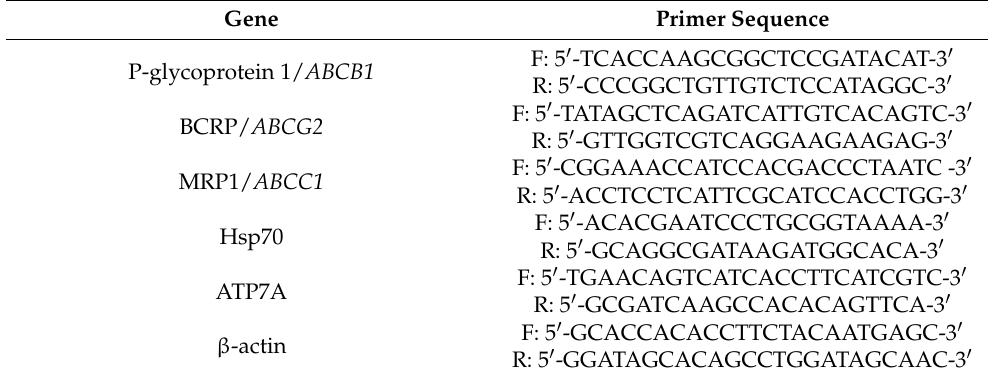
Table 5. Sequences of primers used in reverse-transcriptase polymerase chain reactions (RT-qPCR). Gene Primer Sequence P-glycoprotein 1/